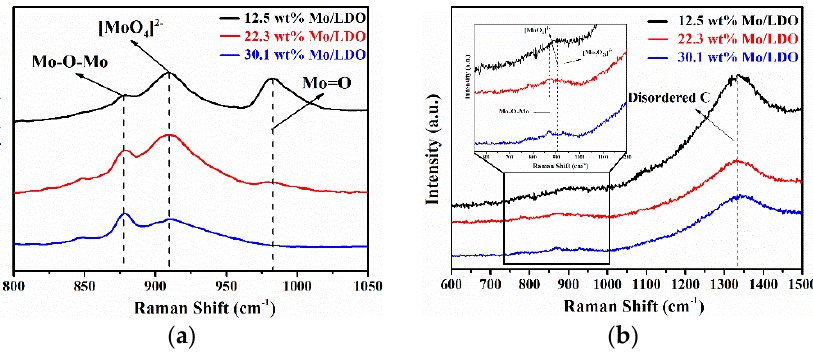
Figure 6. Raman profiles of the ( a ) fresh and ( b ) used Mo/LDO catalysts.